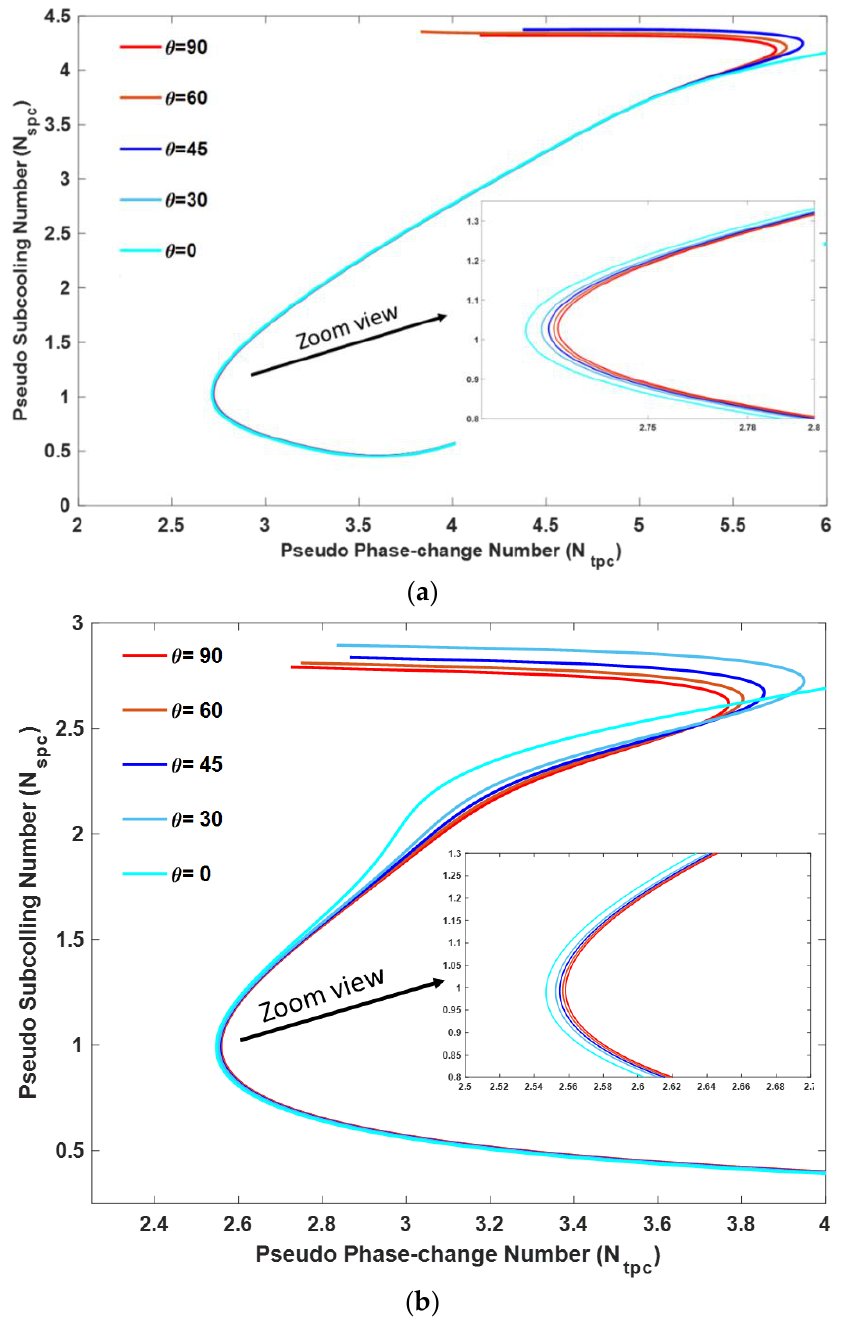
Figure 5. Stability threshold in the N tpc − N spc space at different 𝜃 values. ( a ) Supercritical water (H O) . ( b ) Supercritical carbon dioxide (CO 2